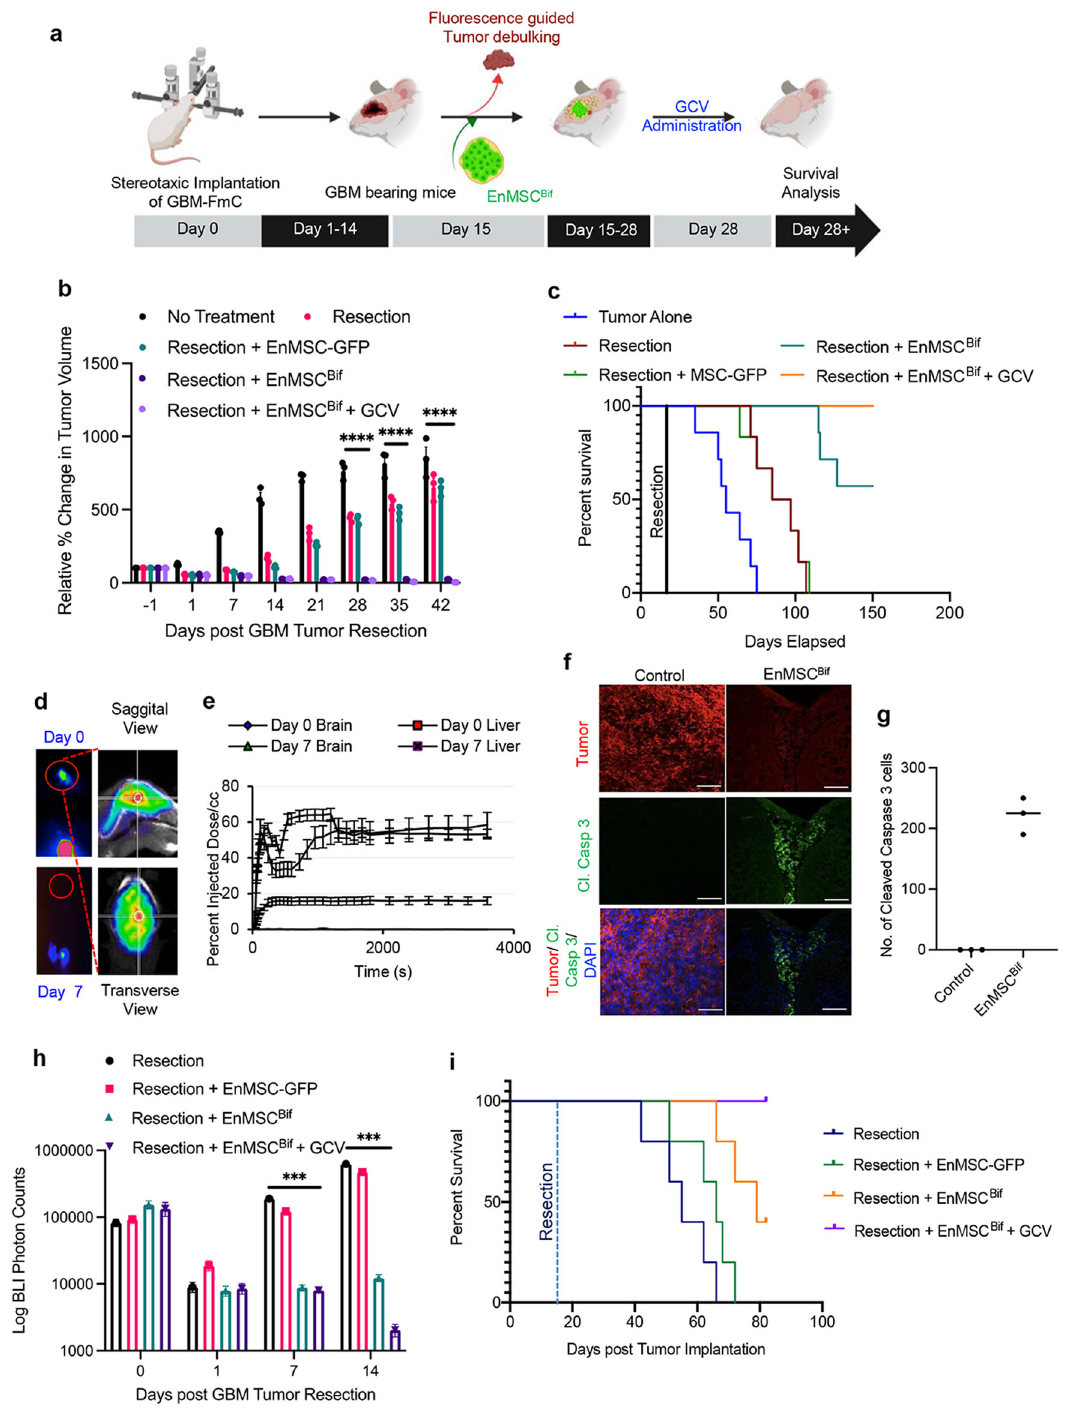
Fig. 6 EnMSC Bif increases survival of mice in a clinically relevant mouse model of GBM resection. a Schematic representing the murine model of GBM resection and treatment. b Plot showing changes in GBM8-FmC tumor volume over time following EnMSC Bif administration post tumor resection as compared to controls. ( n = 5 mice/group. Data representative of three independent experiments; Statistical analyses were done using two-way ANOVA with multiple comparisons). c Kaplan – Meier survival analysis of EnMSC Bif treatment in GBM8-FmC mouse model of resection. d PET images showing brain uptake of [ 18 F] FHBG tracer in mice ( n = 3 mice/group) administered with EnMSC Bif . e Plot representing uptake of the PET tracer, [ 18 F] FHBG in mice administered with EnMSC Bif . f Photomicrographs of immuno fl uorescence imaging of mouse brain sections stained with Cl. Caspase 3 as compared to control. g Plot showing the number of Cl. Caspase 3 cells as compared to control. h Plot showing changes in tumor volumes of GBM31R-FmC bearing mice ( n = 5 mice/group) over time following EnMSC Bif administration post tumor resection as compared to controls. i Kaplan – Meier survival analysis of EnMSC Bif treatment in GBM31R-FmC mouse model of resection. Data are shown as mean ± S.E.M. Scale bars 100 μ M. *** p < 0.01, **** p < 0.001.